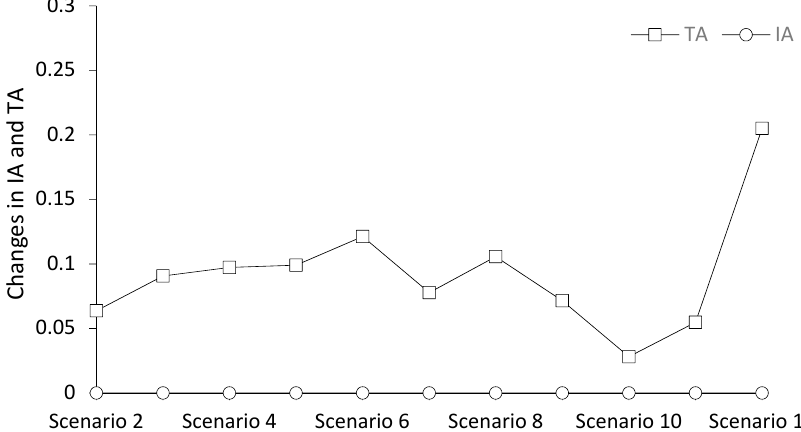
Figure 6. Changes in IA and TA under different numbers of exchanged years.